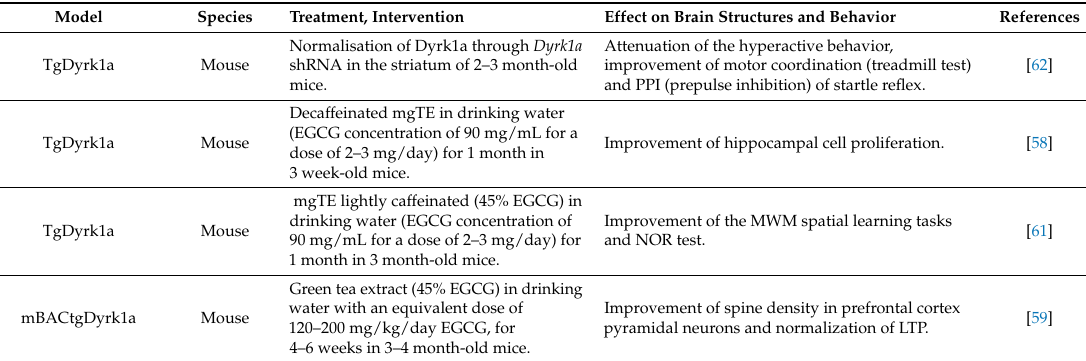
Table 3. Preclinical studies showing the effects of normalizing DYRK1A expression (through genetic approaches) or DYRK1A activity (through EGCG treatment) in mouse and human models of DS. Model Species Treatment, Intervention Effect on Brain Structures and Behavior